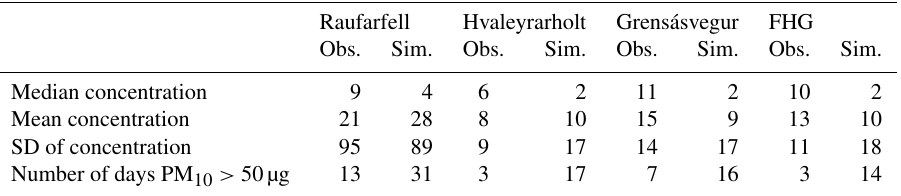
Table 2. Statistics on observed PM 10 concentrations (µgm − 3 ) and simulated dust ( d < 10µm) concentrations (µgm − 3 ) at four stations in Iceland. Raufarfell Hvaleyrarholt Grensásvegur FHG Obs. Sim. Obs. Sim. Obs. Sim. Obs. Sim. Median concentration 9 4 Mean concentration SD of concentration 95 89 Number of days PM 10 > 50µg